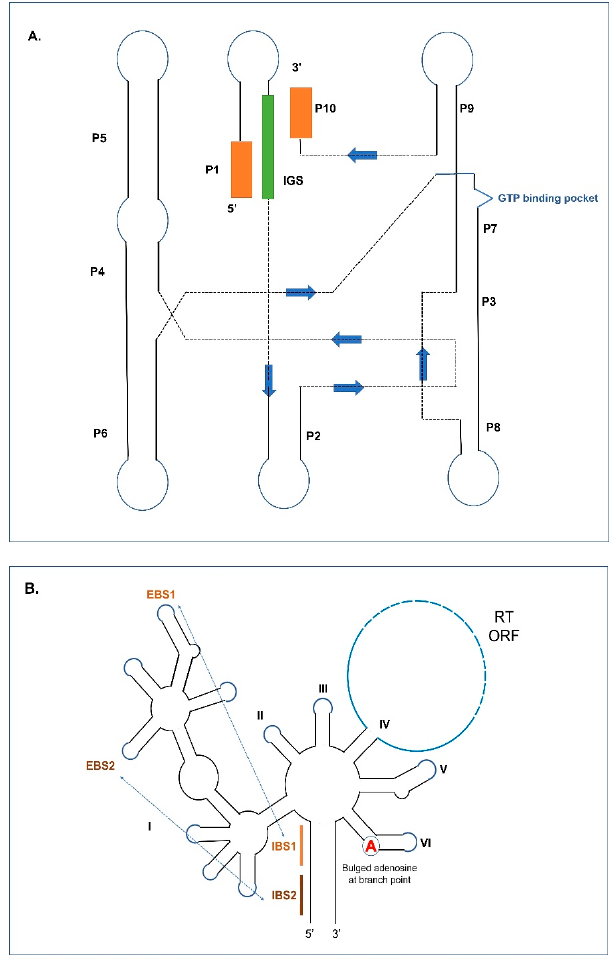
Figure 1. Secondary structure models for Group I and II introns. ( A ) Generic secondary structure representation of Group I intron showing the stem regions (black), loop regions (blue), 5 (cid:48) and 3 (cid:48) exon sequences (orange), and the internal guide sequence or IGS (green). The ten pairing regions (P1–P10) are indicated of which, the P1–P10 interaction is usually critical in determining the splice site. The guanosine-5 (cid:48) -triphosphate (GTP) binding pocket within the P7 helix is also indicated. ( B ) Generic secondary structure of Group II intron showing the six interacting domains (DI-DVI) with the RT-ORF protruding out of the domain IV (blue). Intron and exon binding sequences and the bulged adenosine (A, red) at the branch point are utilized in Group II intron splicing; interactions are indicated as IBS1-EBS1 (orange) and IBS2-EBS2